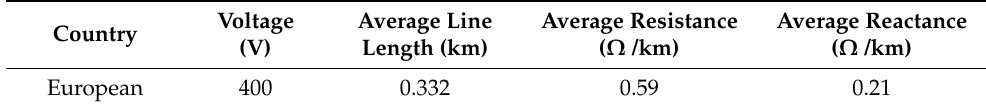
Table A2. Typical line parameters in low-voltage microgrid.